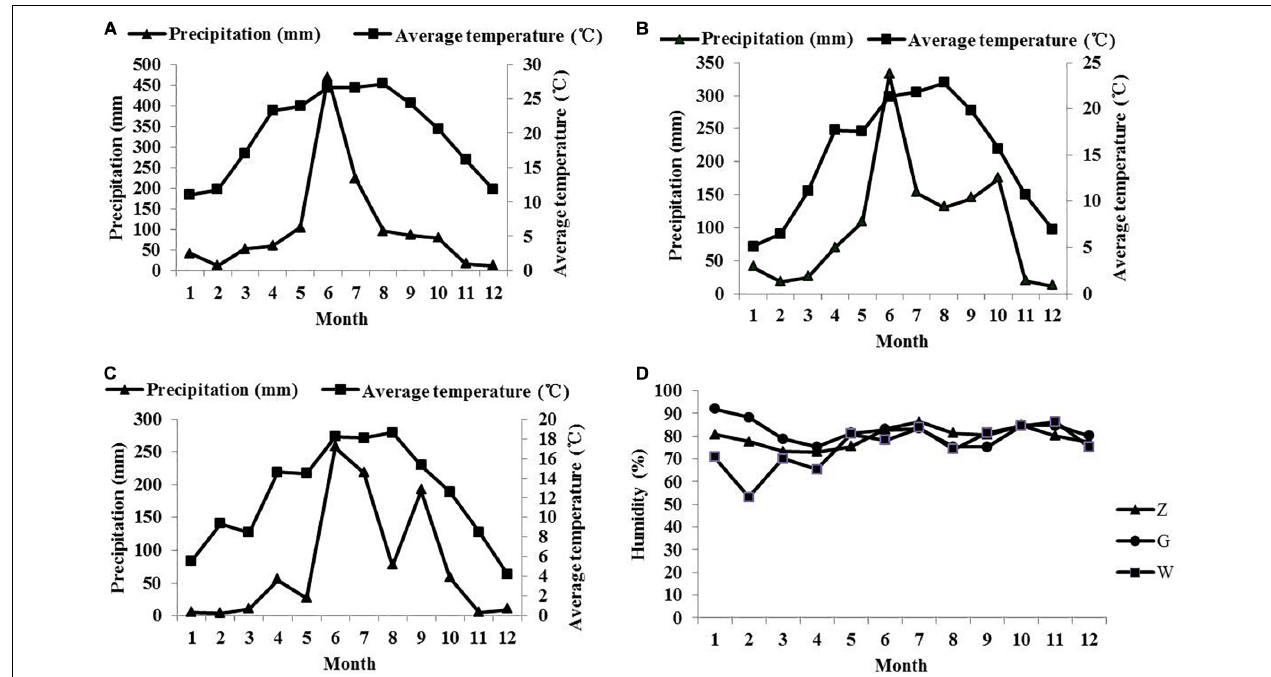
FIGURE 1 | The monthly changes of temperature and precipitation in the area of Ziyun (A), Guanling (B), and Weining (C) in 2019, and monthly humidity changes in three regions (D)